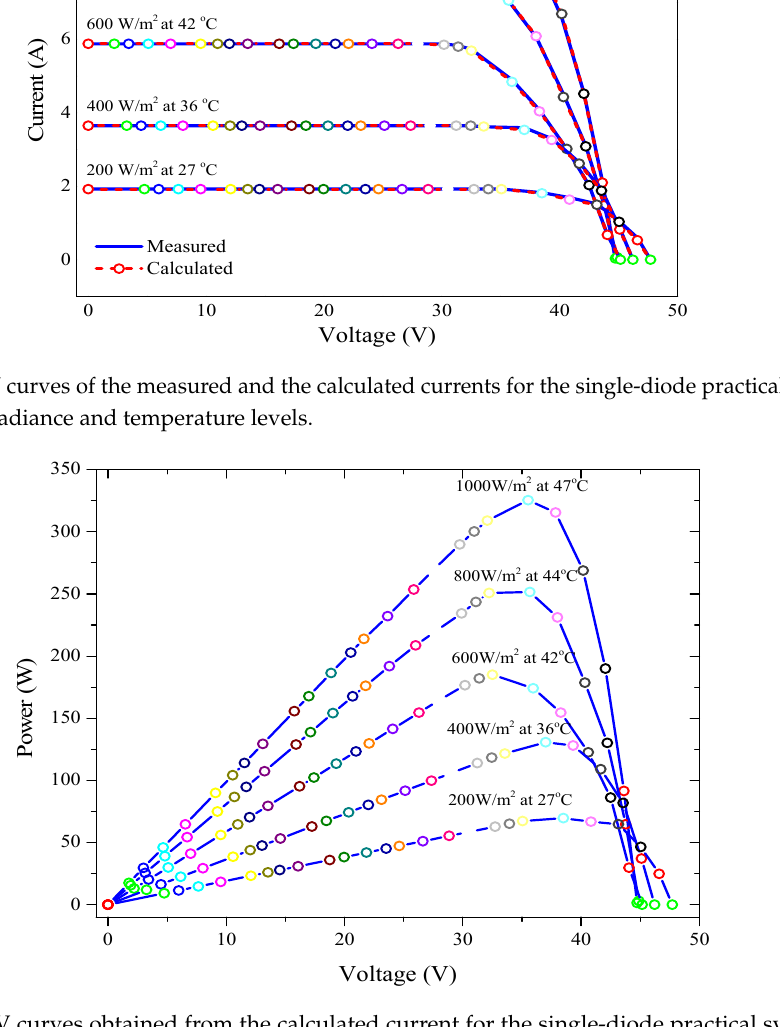
Figure 17. P–V curves obtained from the calculated current for the single-diode practical system at different irradiance and temperature levels.